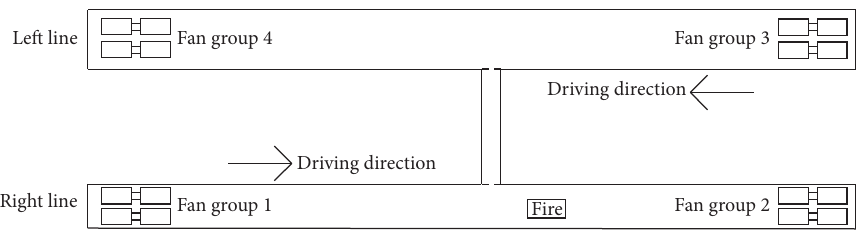
Figure 1: Layout of fan